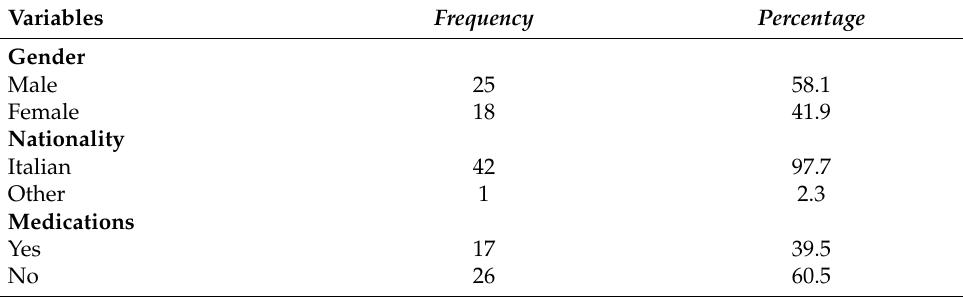
Table 1. Descriptive statistics of the whole